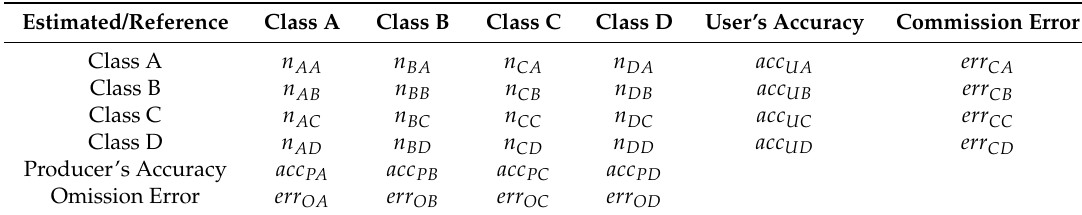
Table 3. Confusion